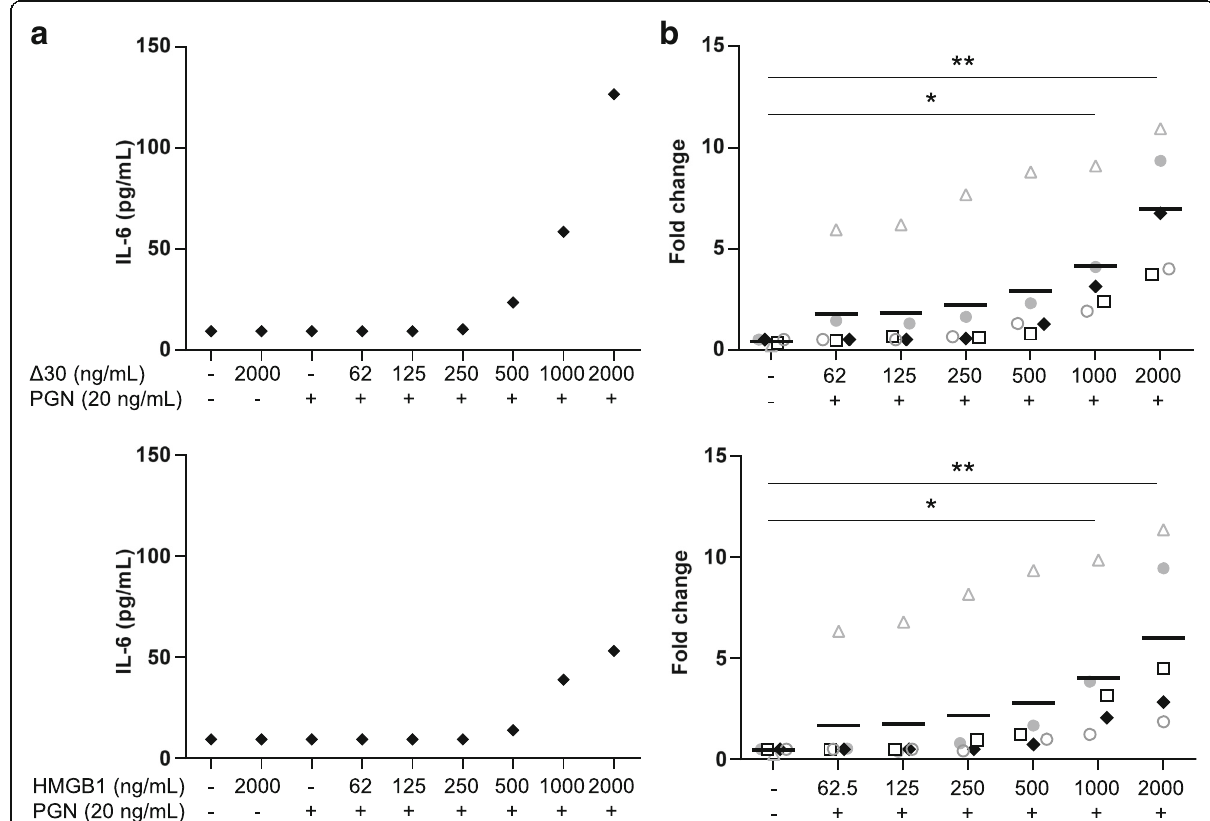
Fig. 3 HMGB1 enhances TLR2 responses to peptidoglycan. PBMCs were isolated from healthy controls and stimulated with HMGB1 or Δ 30 alone or in complex with peptidoglycan (PGN) at the indicated concentrations. Supernatants were collected after 24 h and IL-6 levels were measured by ELISA. a ) Representative cytokine levels from 1 healthy control and b ) Fold change in IL-6 level compared to the control group (IL-6 release with HMGB1 alone + IL-6 release with PGN alone). n = 5